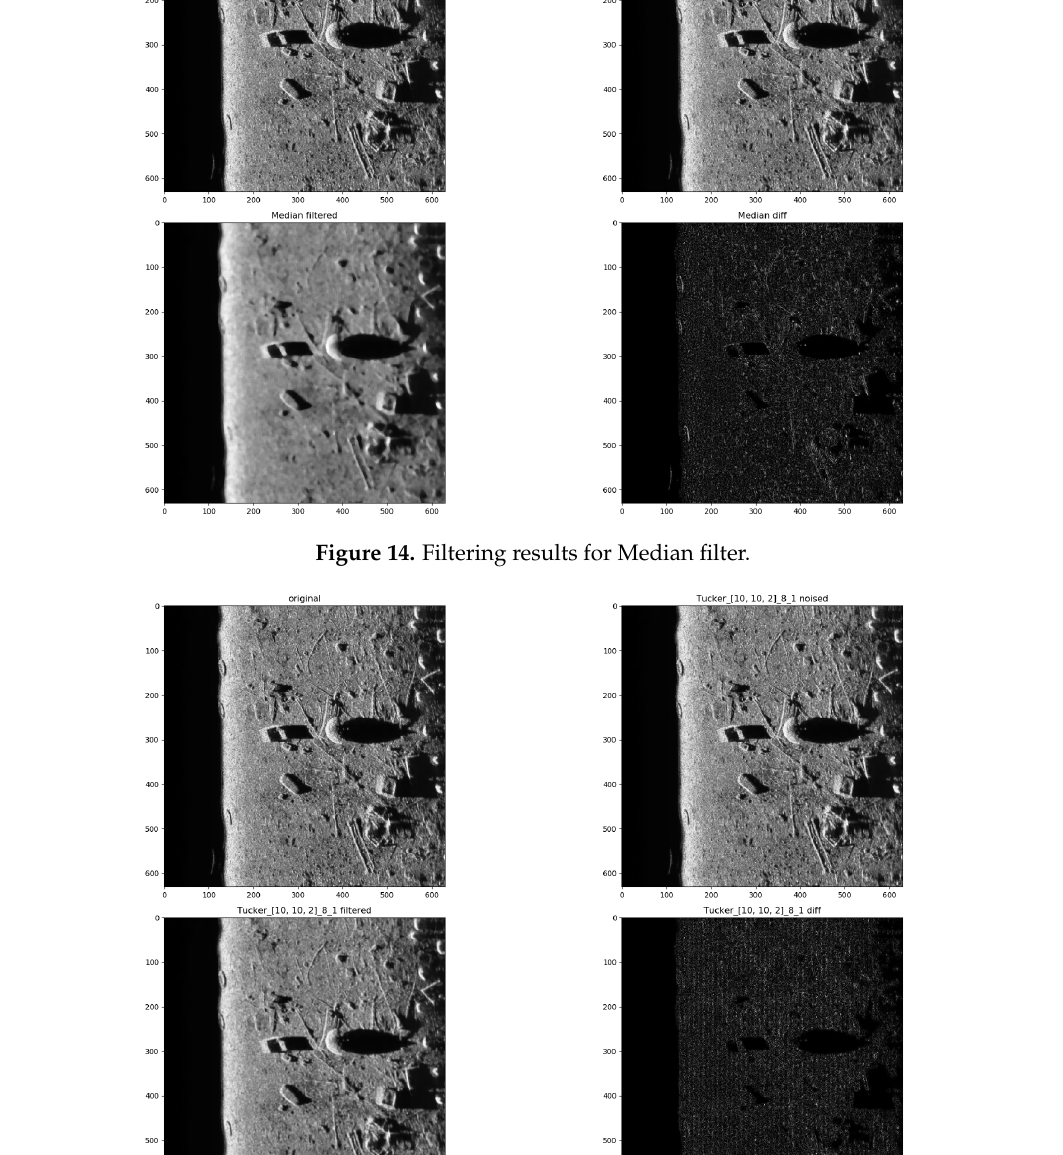
Figure 15. Filtering results for parameters: Tucker rank = [10, 10, 2], window size = 8, close neighbor distance =